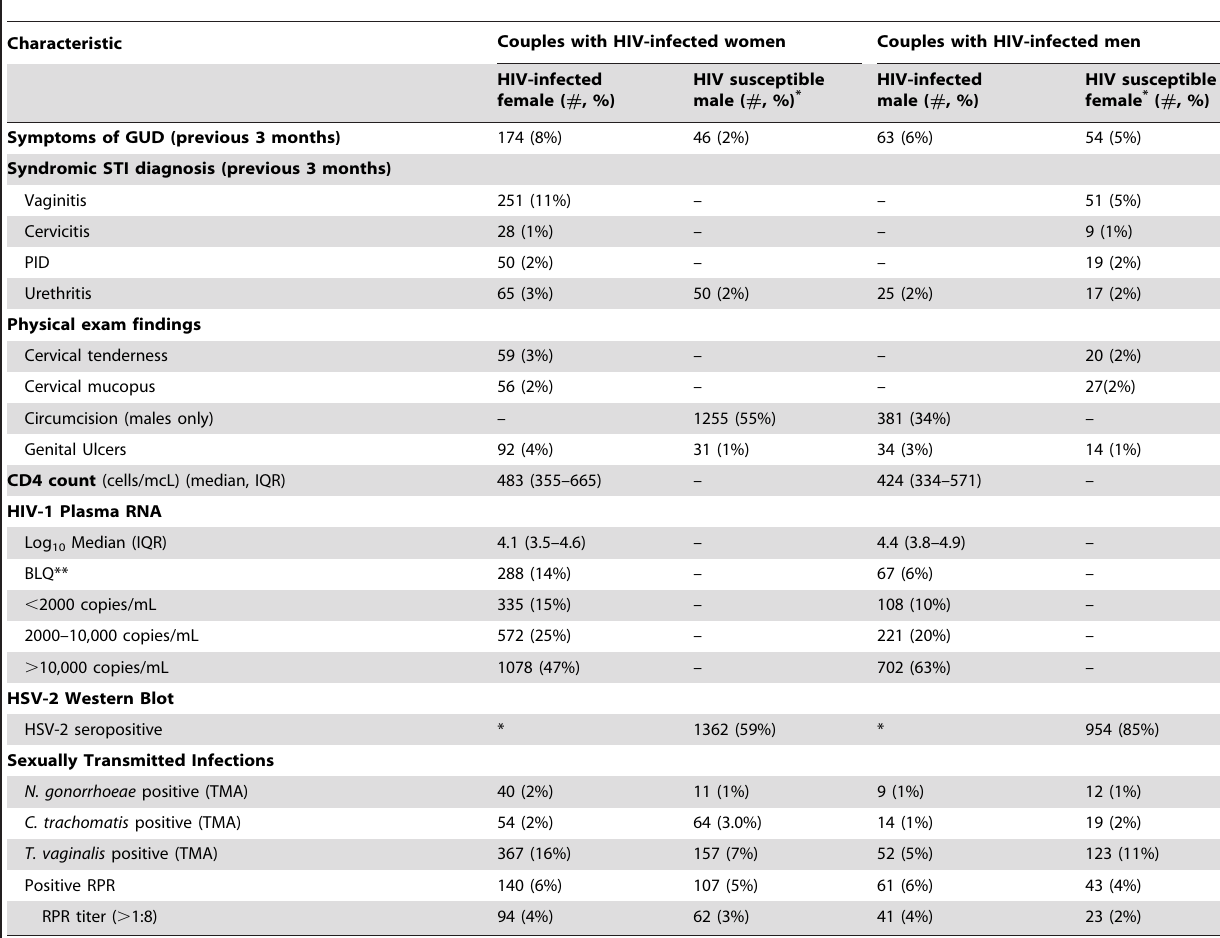
Table 4. Baseline Clinical and Laboratory Characteristics of Enrolled Couples by Gender of HIV-1 Infected